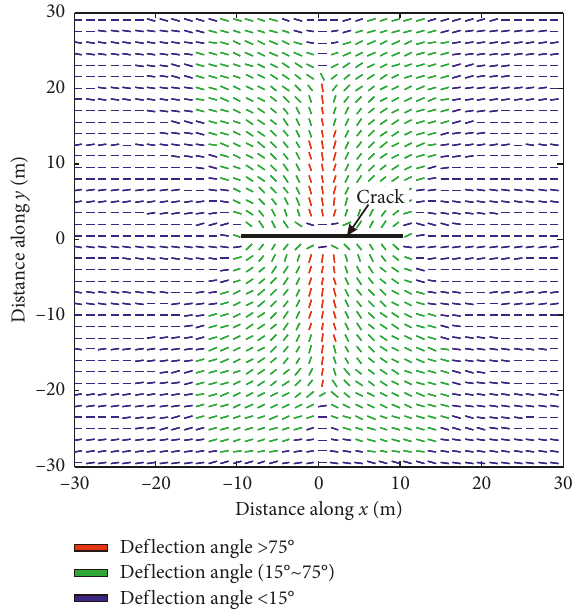
Figure 6: In situ stress deflection after water